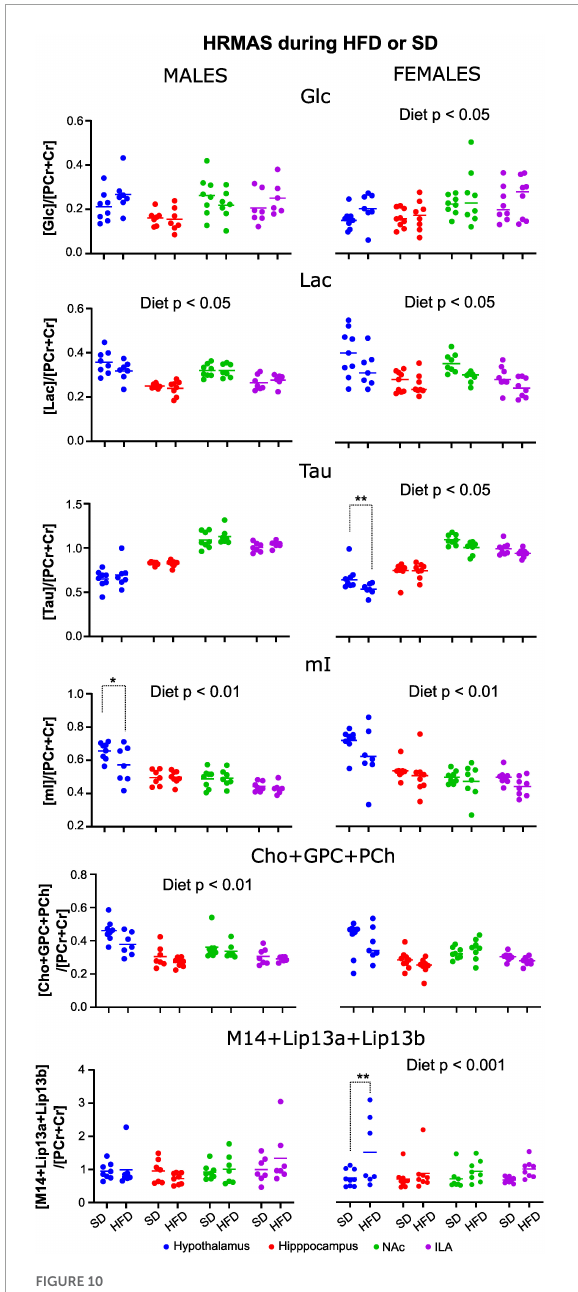
FIGURE10 Relative metabolite concentrations after 10 weeks of HFD or SD consumption in male and female mice. Values of metabolite concentration of male (left) and female (right) animals, fed under a SD or HFD relative to the total creatine resonance. Dots represent the relative concentration obtained for each individual animal, and the continuous line represents de mean value within a diet group. Only those metabolites with significant diet effects are shown. (* p < 0.05, ** p < 0.01).